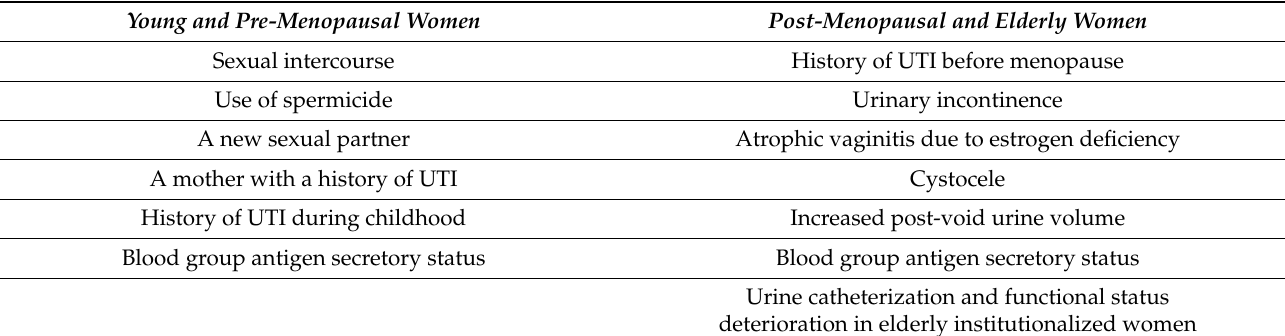
Table 2. The table shows the age-related associations of rUTI in women—EAU guidelines [15]. Young and Pre-Menopausal